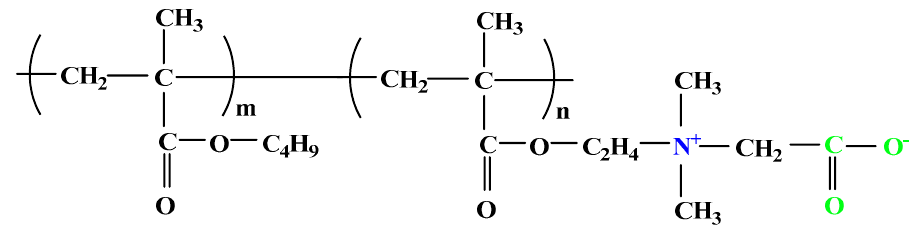
Figure 6. Chemical structure of poly(CMB-r-BMA).